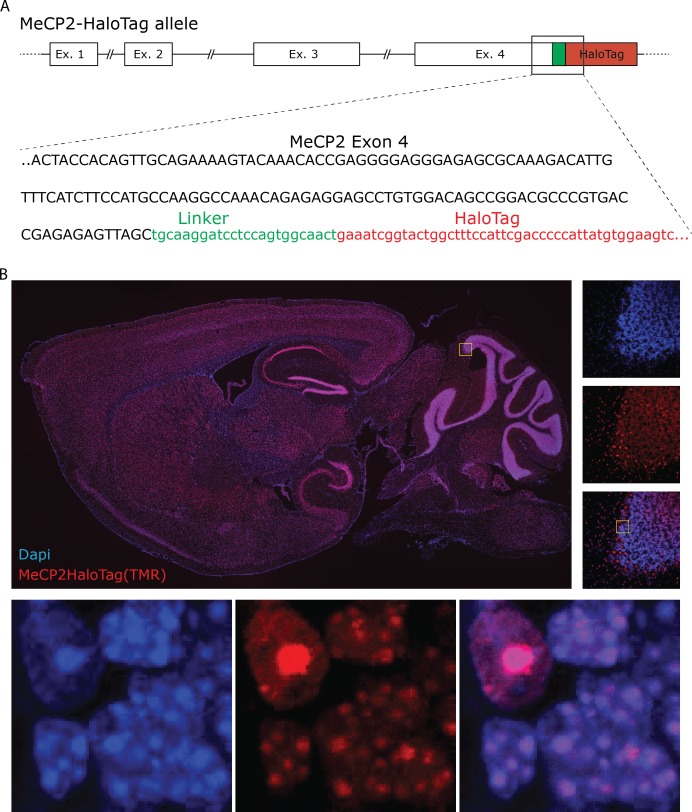
Generation of MeCP2-HaloTag knock-in animals.(A) Genetic sequence encoding for HaloTag was inserted in frame at the 3’ of the last exon of Mecp2 gene to generate an allele that expresses a chimeric molecule with the HaloTag peptide linked to the C-terminus domain of MeCP2 endogenous protein. (B) A sagittal brain slice from MeCP2 HaloTag adult mouse stained with TMR Halo-Ligand. MeCP2-HaloTag recapitulates the expression pattern of MeCP2 in the brain and, at higher magnifications, its nuclear distribution.